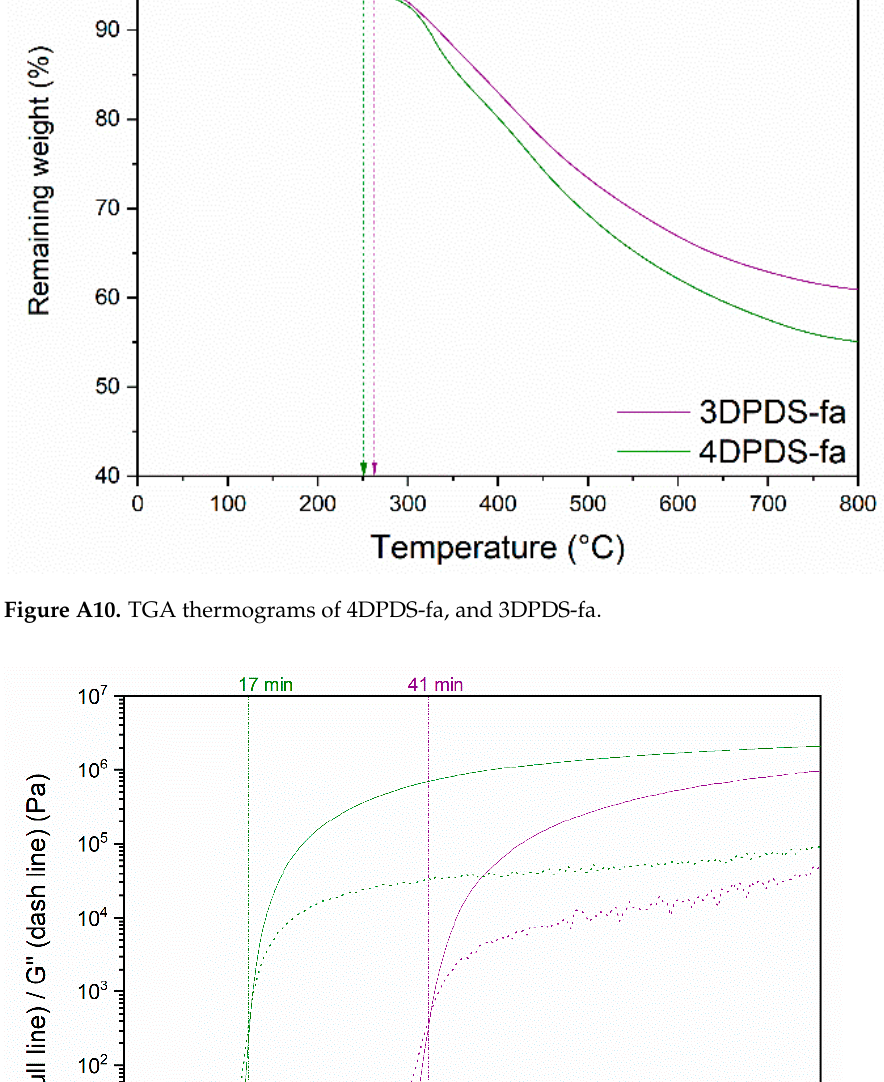
Figure A9. FTIR spectra of 3DPDS-fa, poly(3DPDS-fa) after curing at 170 °C for 1 h, and poly(3DPDS-fa) after curing at 170 °C for 1h and post-curing at 190 °C for 1h and 210 °C for 1 h.